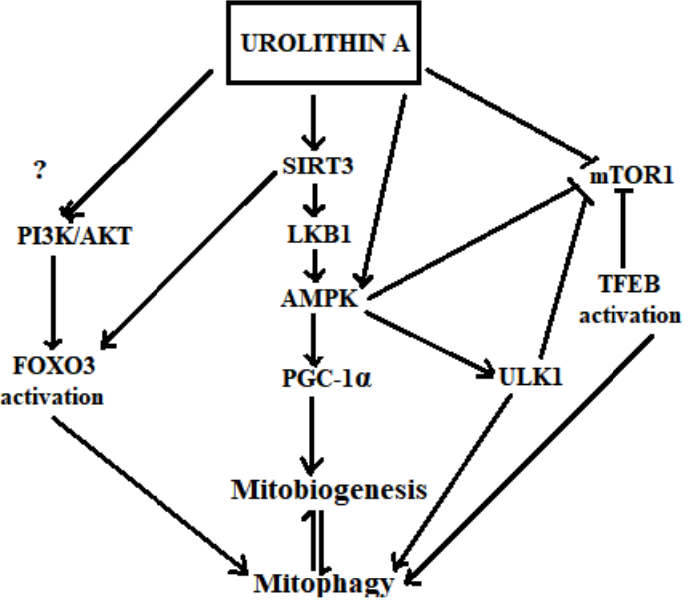
Figure 3. Hypothetical mechanisms of urolithin A in inducing mitophagy. Urolithin A activates SIRT1, SIRT3 [216] and AMPK. Activated AMPK increases PGC-1 α levels [108] that directly increases mitochondrial biogenesis, which is in equilibrium with the mitophagy process. Activated AMPK also increases the activation of ULK1 [66]. Inhibition of mTOR1 is triggered by both urolithin A [217] and AMPK, which then activates ULK1 towards inducing mitophagy. The mTOR1 inhibition by Urolithin A may also induce the transcriptional activation of mitophagy via TFEBs. Urolithin A transcriptionally activates mitophagy via SIRT3-dependent FOXO activation [218,219].